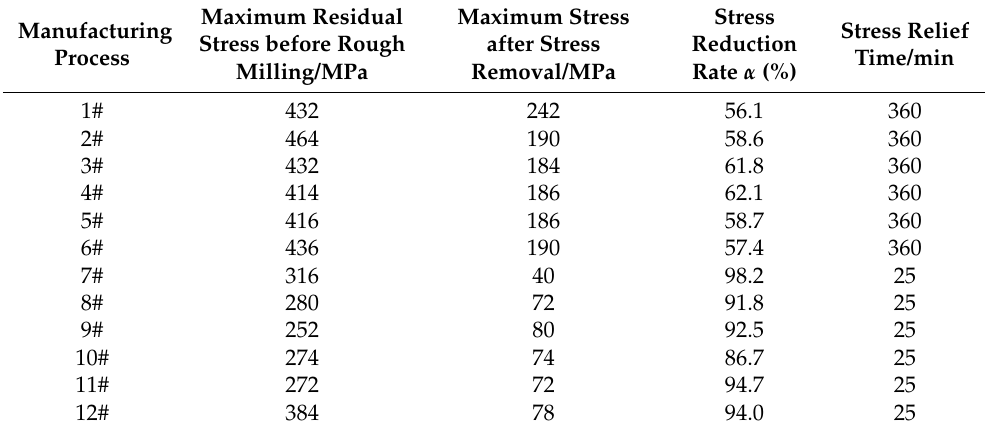
Table 3. Control process parameter heat treatment destressing vs. ultrasonic